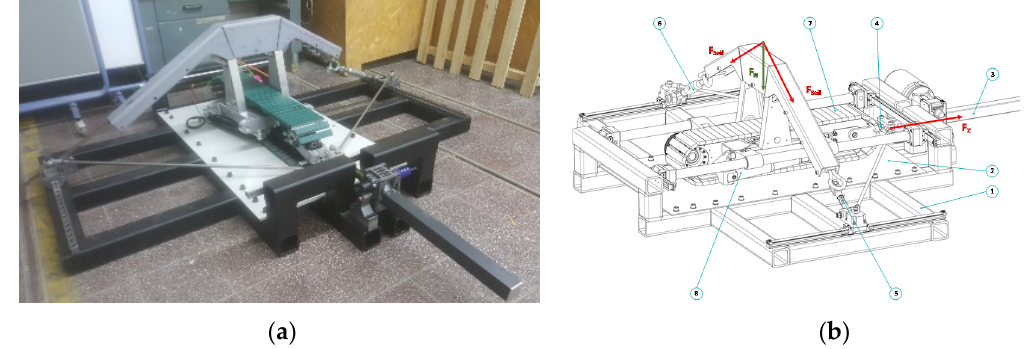
Figure 12. Friction test bench: experimental assembly ( a ); system overview ( b ).